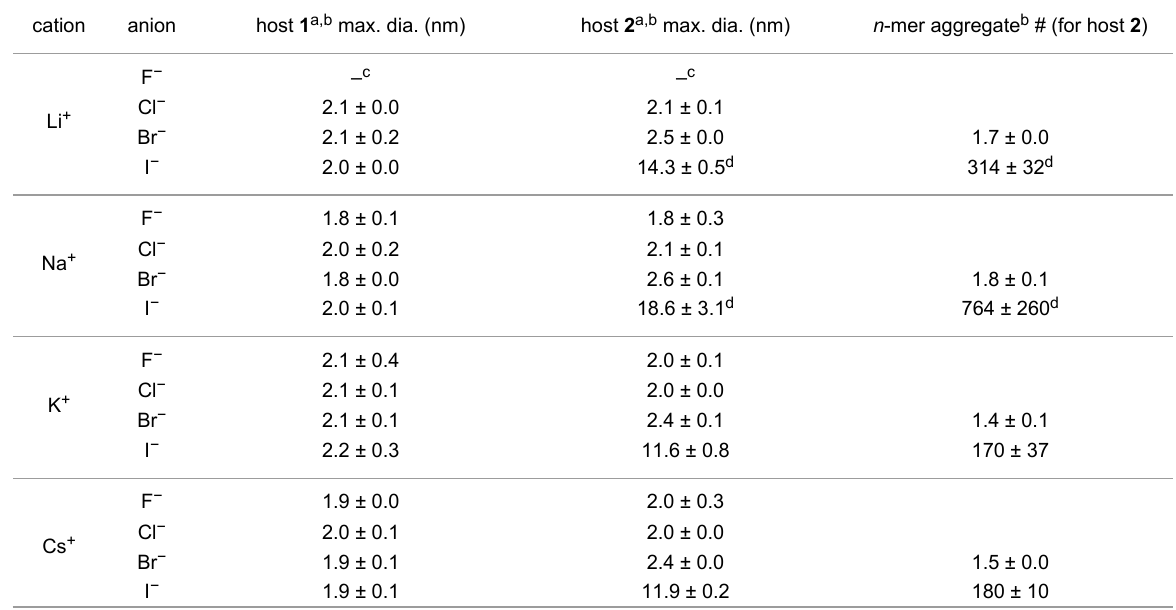
Table 1: Summary of titration data from DLS